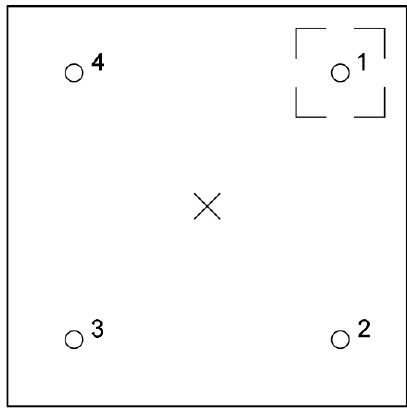
Table 4. Integral and RMS of frequency spectrum, void below sensor 1.